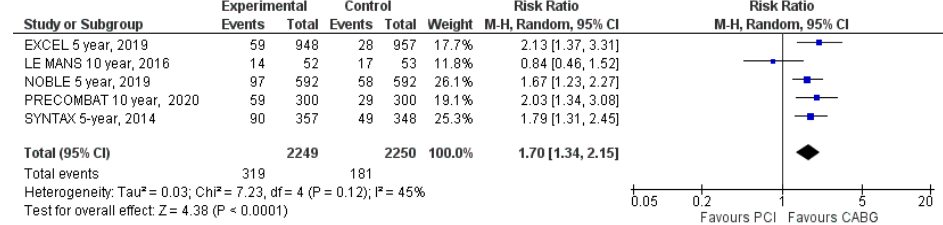
Figure 7. Risk of repeat revascularization at the latest follow-up: PCI vs. CABG.